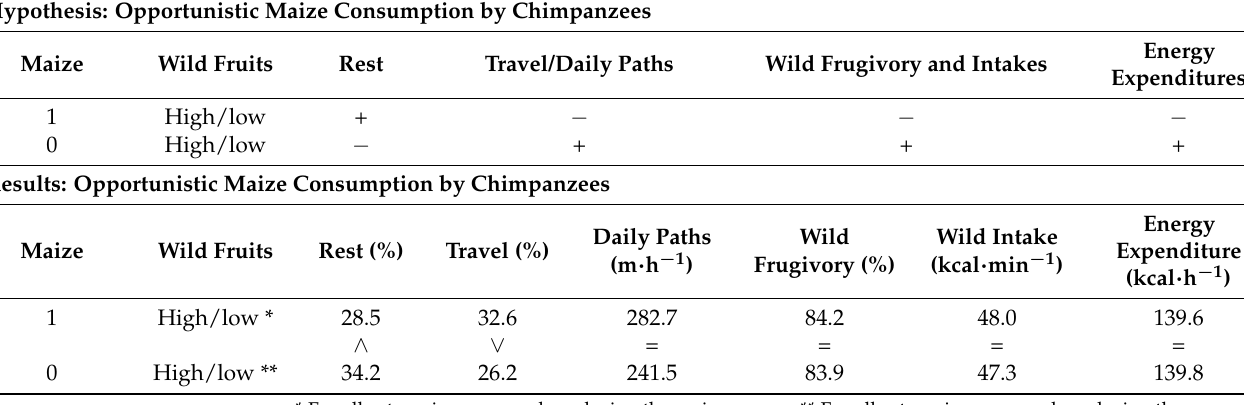
Table 7. Verification of the main hypothesis and summary of the results from this